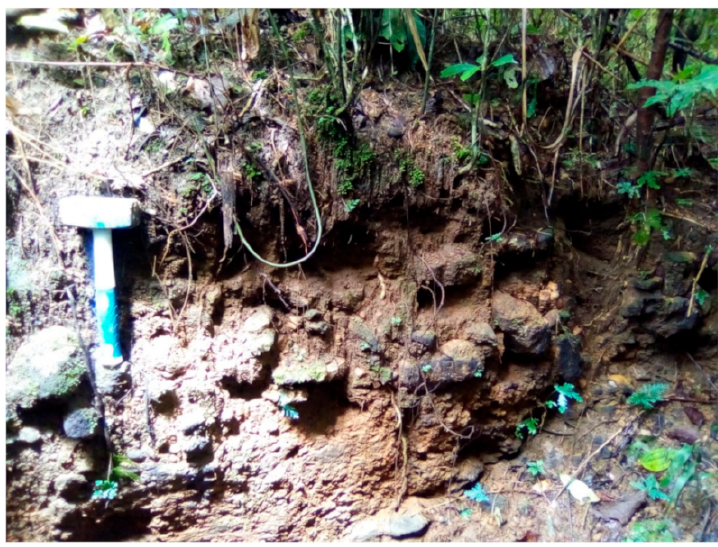
Figure 17. Section of a 2-m excavation dug parallel to the E-W direction for sampling resistant boulders rich in Mn at Neghe village (Hammer used as the scale is 25 cm